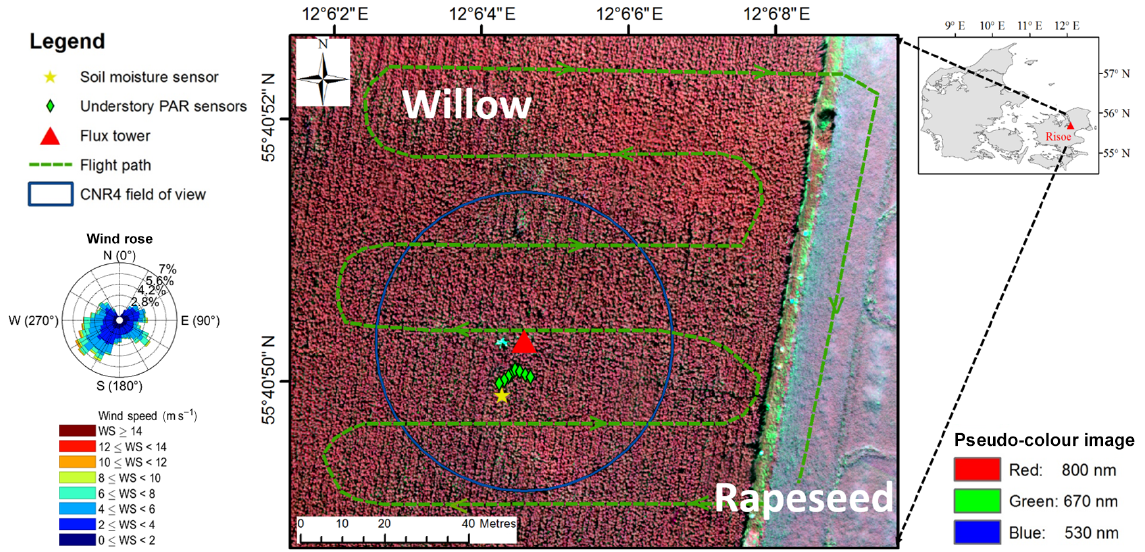
Figure 1. Overview of the Risoe willow plantation eddy covariance flux site. The flux tower is the red triangle in the middle of the willow plantation; the green dashed line shows the typical flight path of the UAS; green diamonds indicate the location of the understory photosyn- thetically active radiation (PAR) sensors; the yellow star refers to the soil moisture sensor; the blue circle indicates the net radiometer field of view. The wind rose refers to the wind direction and frequency in 2016. The base map is a multispectral pseudo-colour image collected on 1 August 2016 with 800, 670, and 530nm as the red, green, and blue channels respectively. Table 1. NDVI, surface temperature, and soil moisture information from the UAS and in situ data. ∗ indicates that no data were available from the UAS due to technical issues; thus, in situ data were used to represent UAS snapshots. f IPAR is the fraction of intercepted PAR, T s is the land surface temperature ( ◦ C), and θ is the volumetric soil moisture (m 3 m − 3 ). For the methods used for θ estimation and detailed weather conditions, please refer to Wang et al.